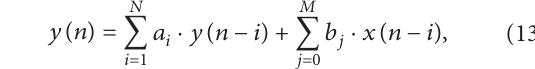
Figure 2: The distribution of the fitness of ESMA and compared algorithms on 30 benchmark Figure 3, the convergence curves of ESMA are superior to other compared methods on almost all test functions. The convergence curves of ESMA indicated that, in most cases, ESMA achieves faster convergence rates and better con-